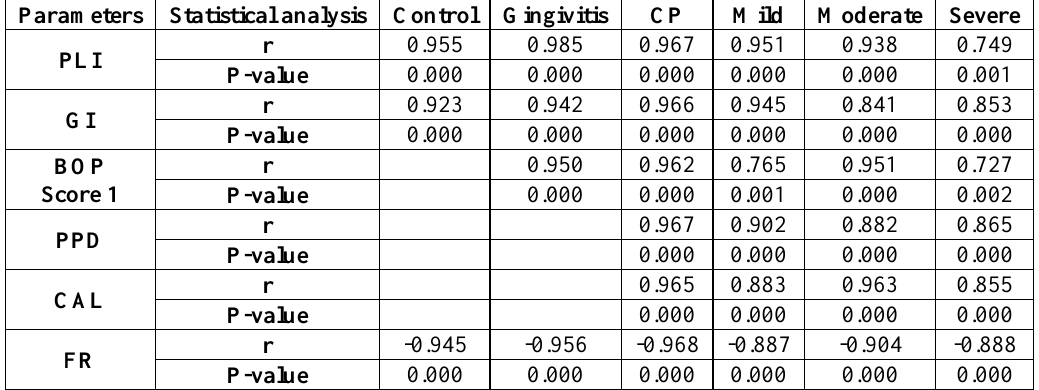
Table 5: Correlations between the levels of salivary α-Amylase with the clinical parameters of groups and subgroups